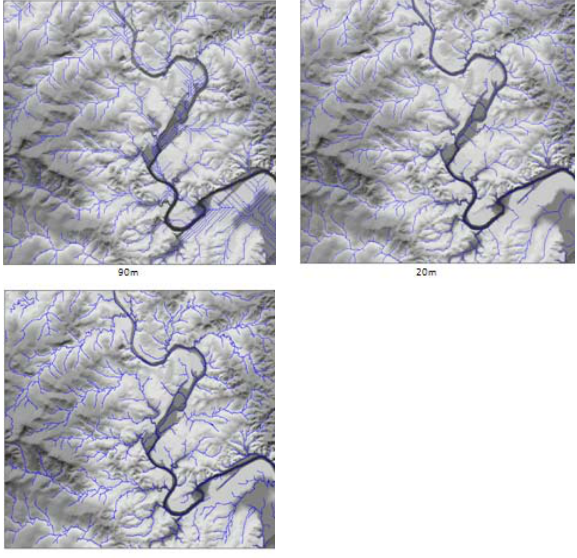
Figure 6. Data derived from available DEMs